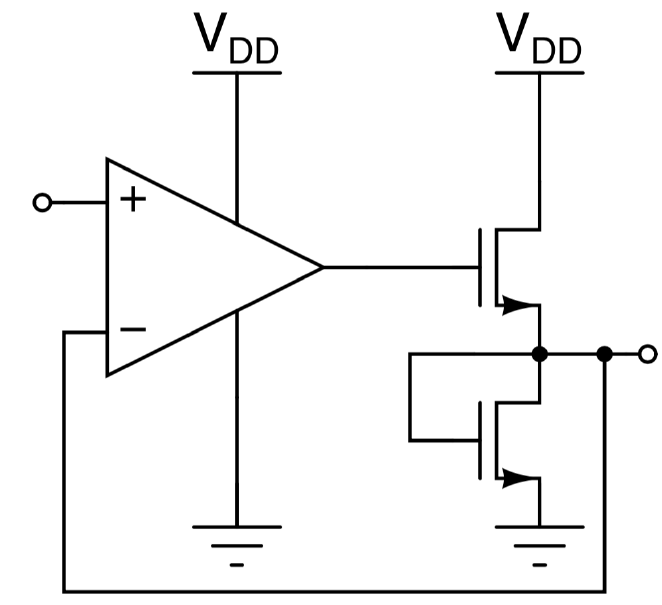
Figure 14. Voltage buffer added in the amplifying